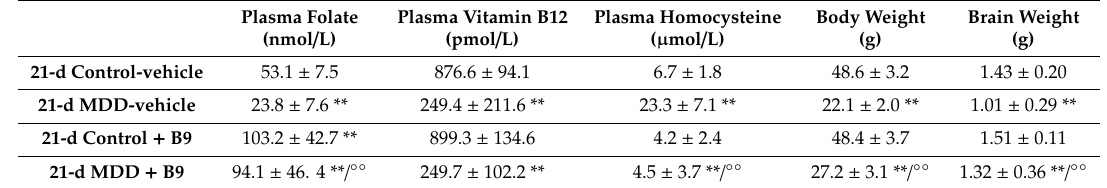
Table 1. E ff ects of the maternal dietary regimen on plasma concentrations of folate, vitamin B12, homocysteine, body weight and brain weight in 21-day-old rat pups.